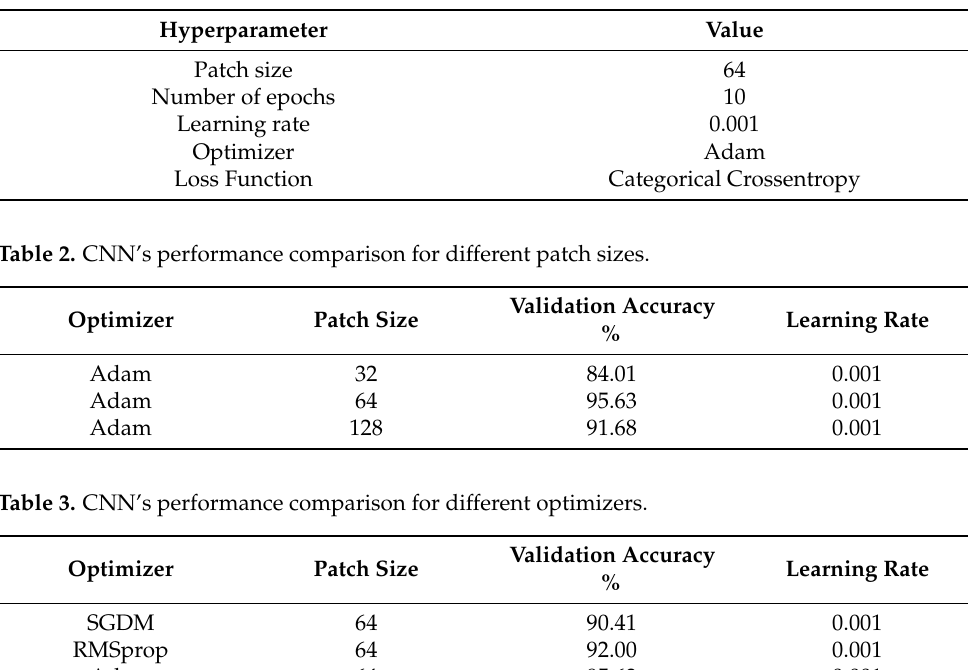
Figure 10. Using ResNet-50 model in the proposed technique. Table 1. CNN’s optimal hyperparameters.